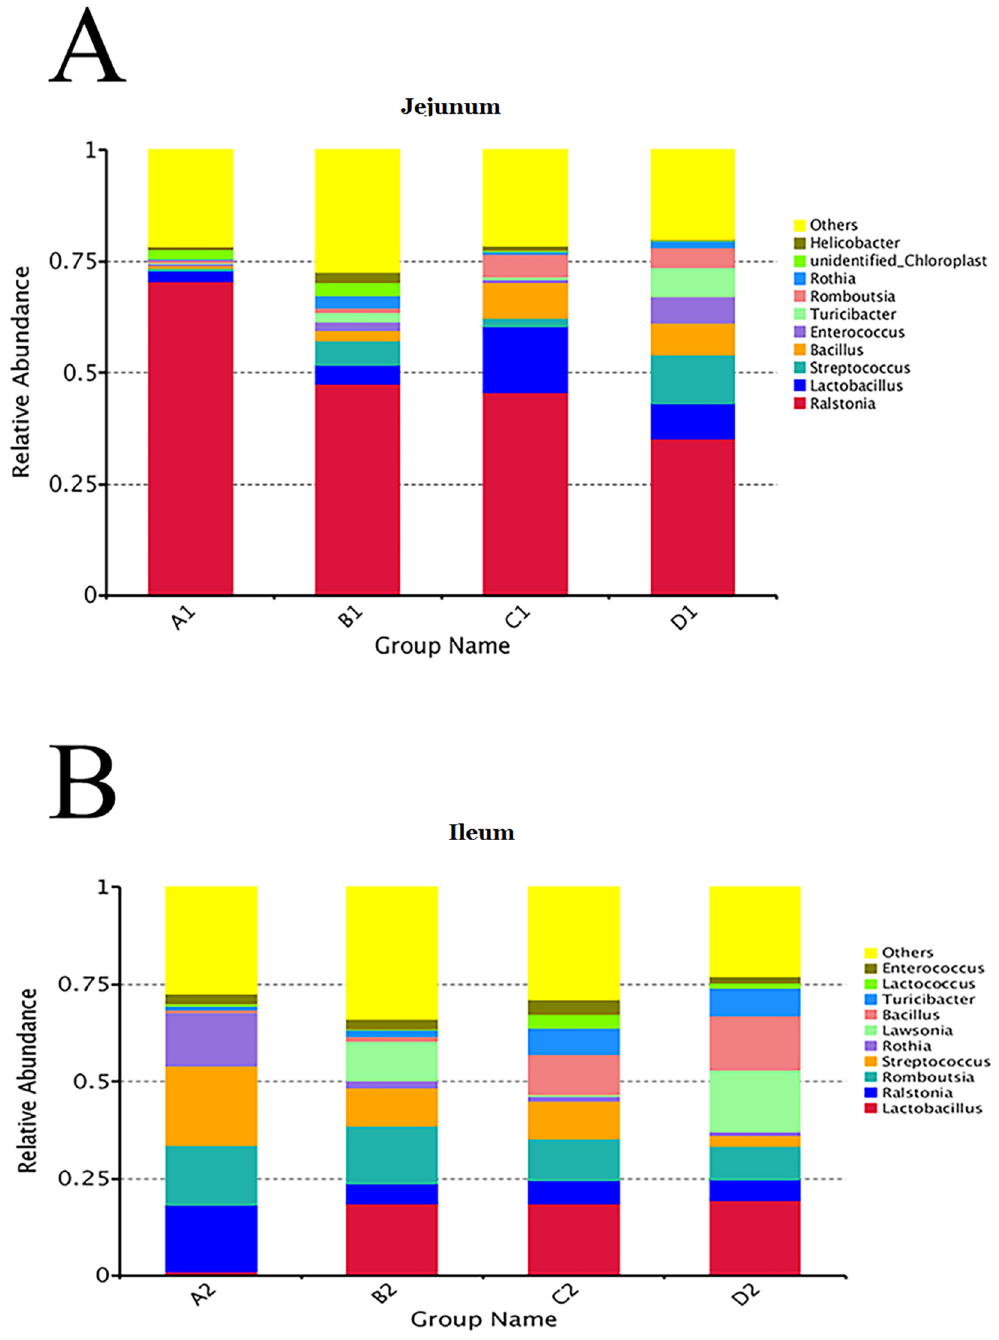
Figure 6. Relative abundance of bacteria in jejunal ( A ) and ileal ( B ) contents at genus level. Note: Group A (as control) was fed a basal diet, the treatment groups (B, C and D) were fed the basal diet supplemented with 250 mg/kg Clostridium butyricum (viable count 3.0 × 10 6 CFU/g), 250 mg/kg Bacillus subtilis (viable count 2.0 × 10 7 CFU/g), or the combination of 250 mg/kg Clostridium butyricum plus 250 mg/kg Bacillus subtilis, respectively. n =